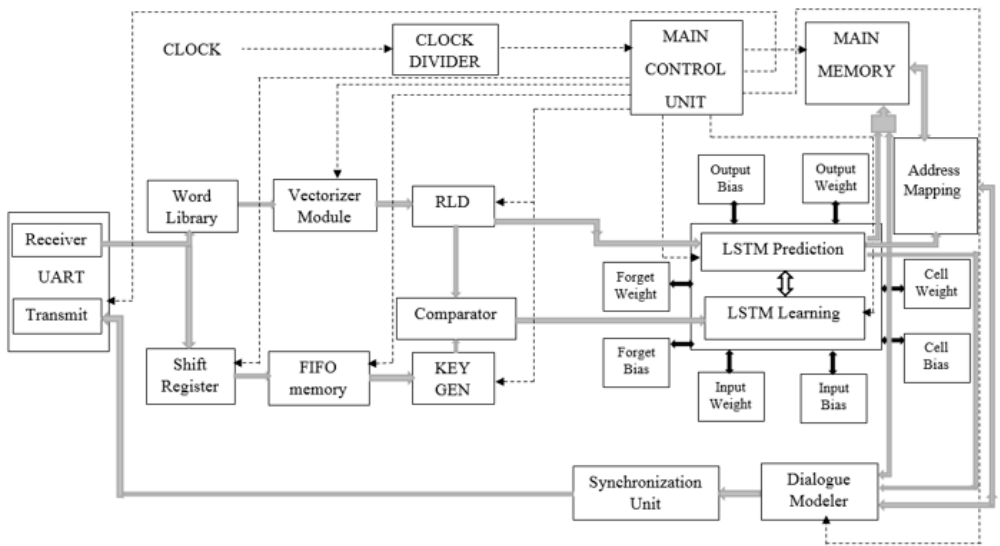
Figure 8. Long Short Term Memory Cell (LSTM) decoder.